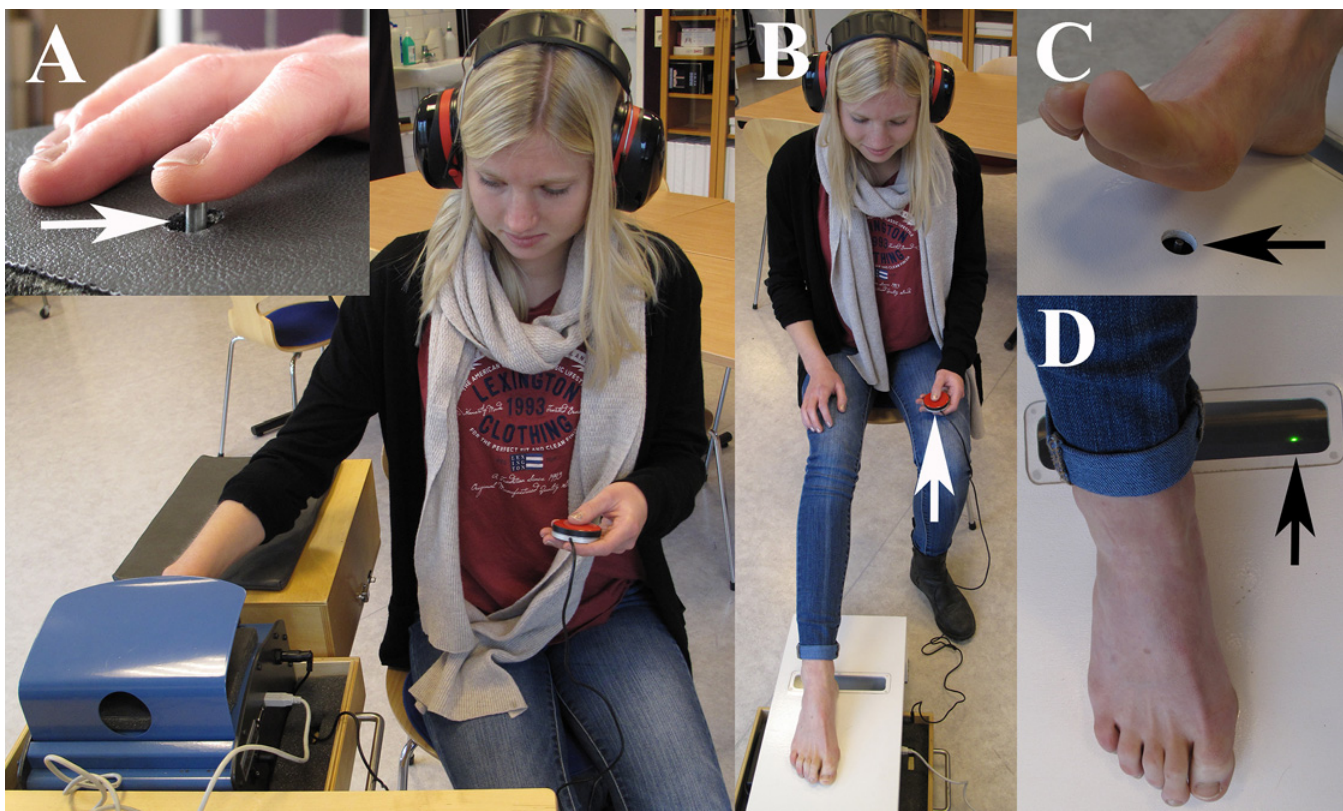
Fig 1. Photo showing the experimental set-up. The subject is sitting with the arm/hand and leg/foot, respectively in a relaxed position (A). The investigated skin area (index or little finger, head or the first or fifth metatarsal bone or heel) is placed on a vibrating probe (insert). The subject regulates the intensity of the vibration by pressure a button on a remote control (arrow) in his/her contralateral hand (B). The result is a tactilogram (see Fig. 2). The probe for the foot is shown in (C) and the green light (D) indicates that the pressure is appropriate on the investigated area. The person on the photo is not one of the subjects in the